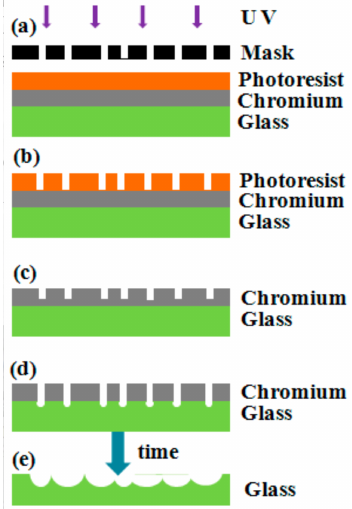
Figure 1. The procedure of fabricating randomly distributed microwell arrays: ( a ) a glass with chromium plating was used as substrate, and exposure was carried out with designed mask; ( b ) photoresist-based structure was achieved after development; ( c ) the photoresist pattern was transferred to the surface of the chromium film; ( d ) acid etching; ( e ) random distribution of microwell